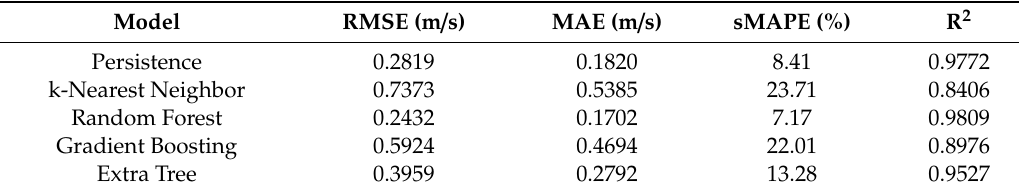
Table 4. Comparison of various models based on test data.